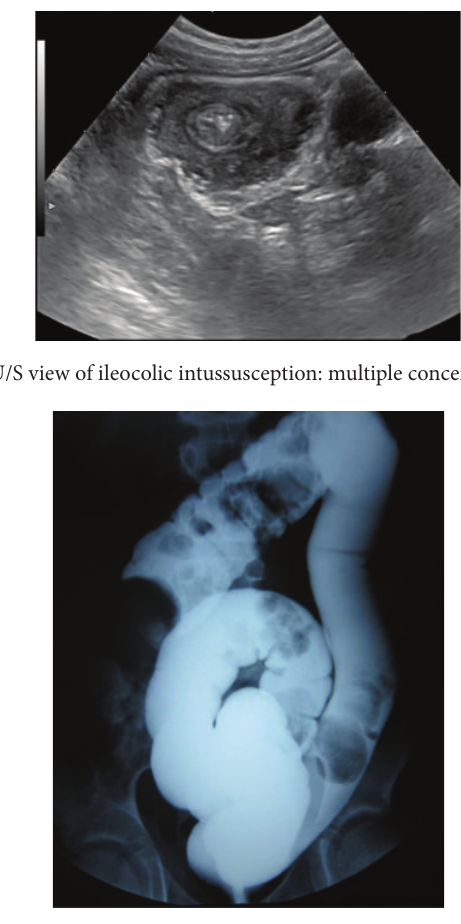
Figure 2: Barium contrast enema: configuration of the unsuccessfully reduced intussusception in the right upper quadrant.